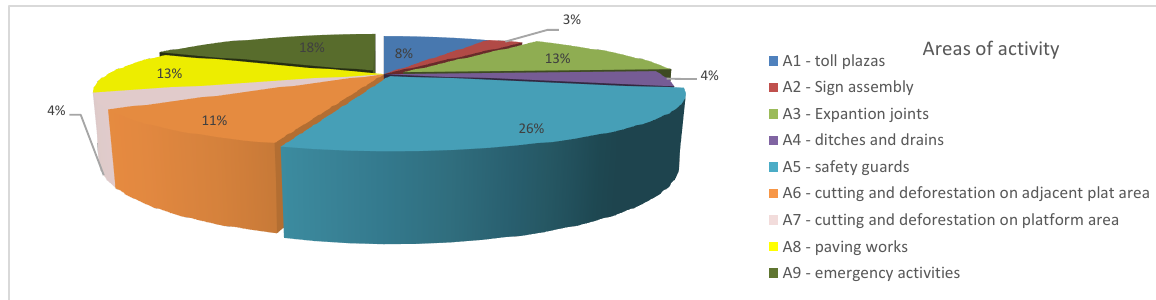
Figure 5. Safety measures by